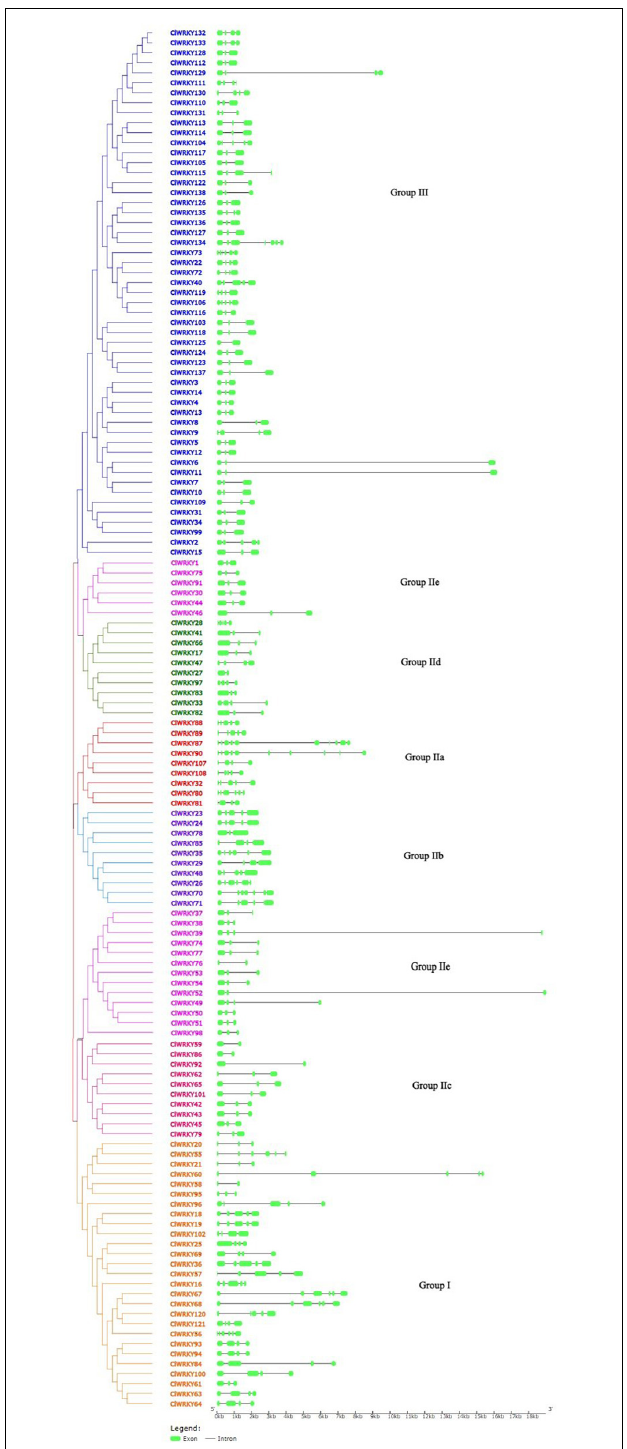
FIGURE 3 | The intron-exon structure of 138 ClWRKY members according to the phylogenetic relationship. A phylogenetic tree was constructed with the ClWRKY protein sequences using MEGA X. The Gene Structure Display Server (GSDS) software was used to determine the intron-exon structure. Green bars represent exons in the gene. Different colors of WRKY members represent different groups in the ClWRKY